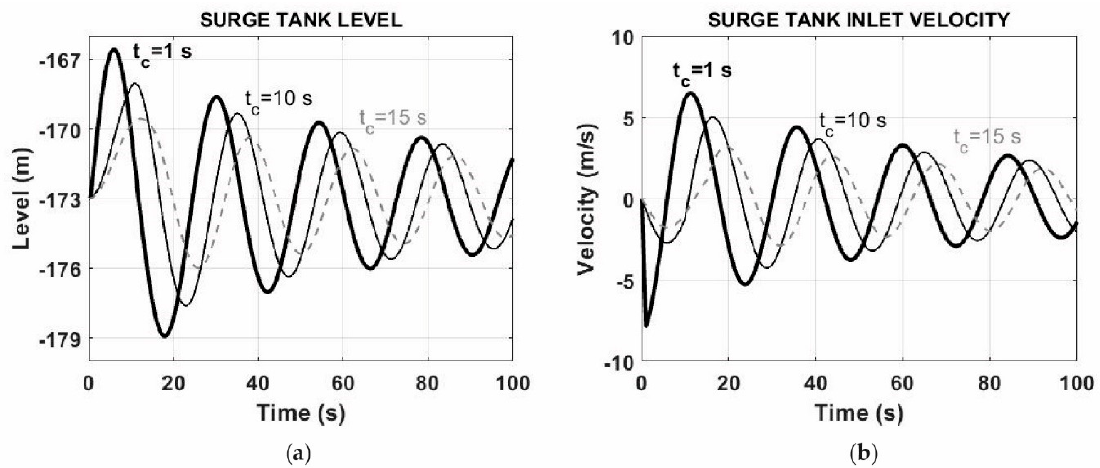
Figure 5. Hydraulic transient analysis. ( a ) Water level fluctuation in the surge tank for t c =1, t c =10 and t c =15 s of closure time of guide vanes; and, ( b ) Surge tank water inlet velocity for t c =1, t c =10 and t c =15 s of closure time of guide vanes.